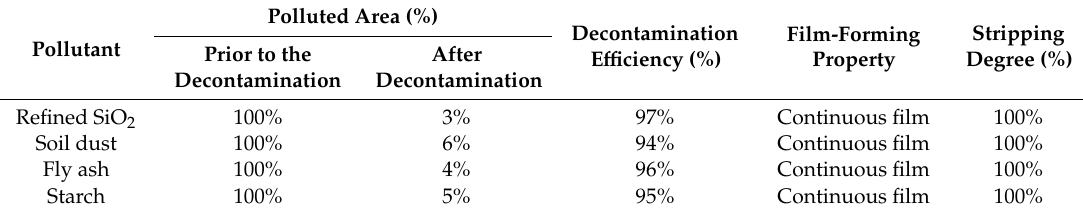
Table 3. Decontamination efficiency of the decontaminant.